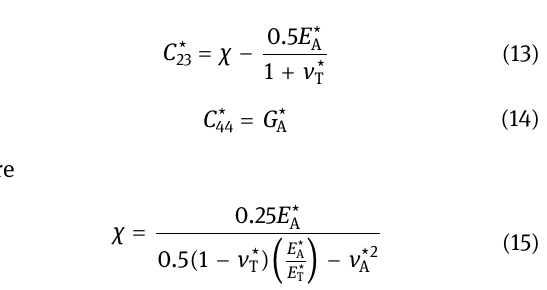
Figure 4: A numerical model of the full RVE for ( a ) square and ( b ) hexagonal distribution of